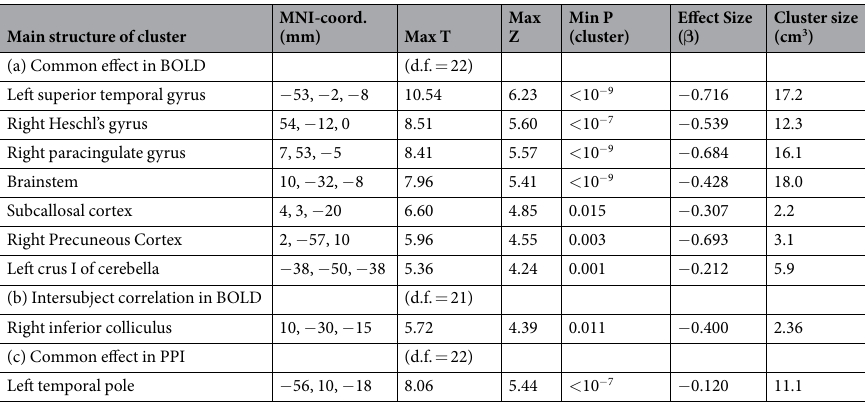
Table 1. Statistics of the significant clusters with the effect of dissonance. Significance of a cluster was determined by an extent threshold that controls the family-wise error rate (FWER) less than 0.05 (see Methods). (a) Common effect of dissonance in BOLD signal, (b) intersubject correlation between the rating contrast and the BOLD contrasts, (c) common effect of dissonance in psychophysiological interaction (PPI) between the psychological contrast of dissonance and inferior colliculus activity. Identification of anatomical structures was based on Harvard–Oxford cortical/subcortical structural atlases provided in FSL (https://fsl.fmrib.ox.ac.uk/). Abbreviations: BOLD, blood-oxygen-level dependent signal; d.f., degrees of freedom.